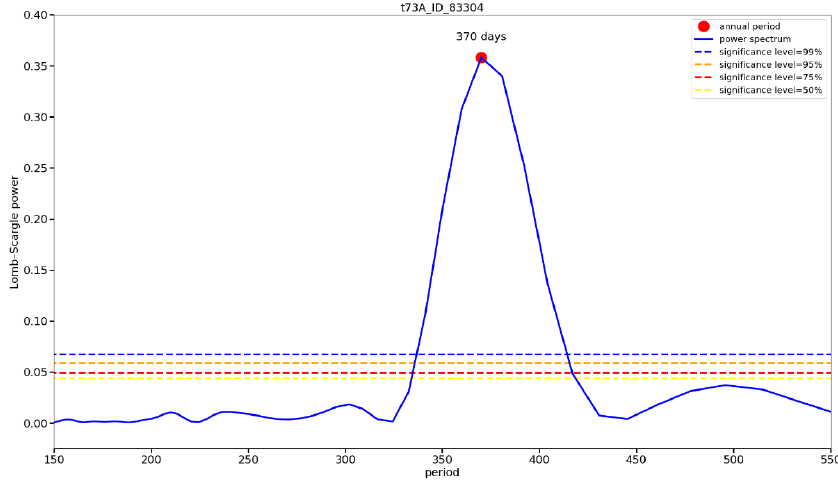
Figure 8. Lomb–Scargle periodogram for a time series of one PS point with an indication of the annual period corresponding to one injection/withdrawal cycle (adjusted according to [27]).